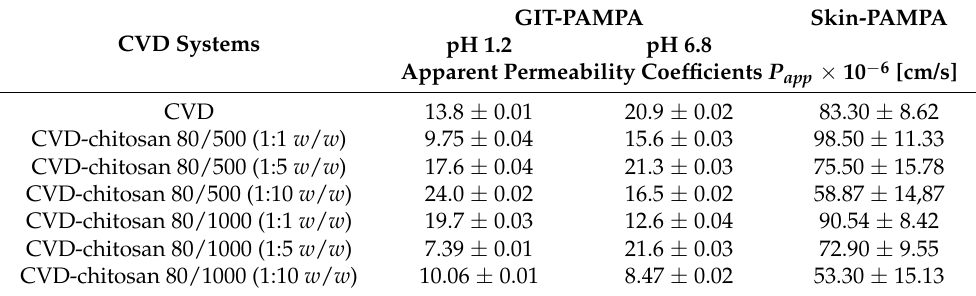
Figure 5. SEM images of CVD at 1000 × ( A ) and 10,000 × ( B ) magnification. Table 1. Calculated apparent permeability coefficients of CVD and CVD-chitosan systems for GIT- PAMPA and Skin-PAMPA tests.